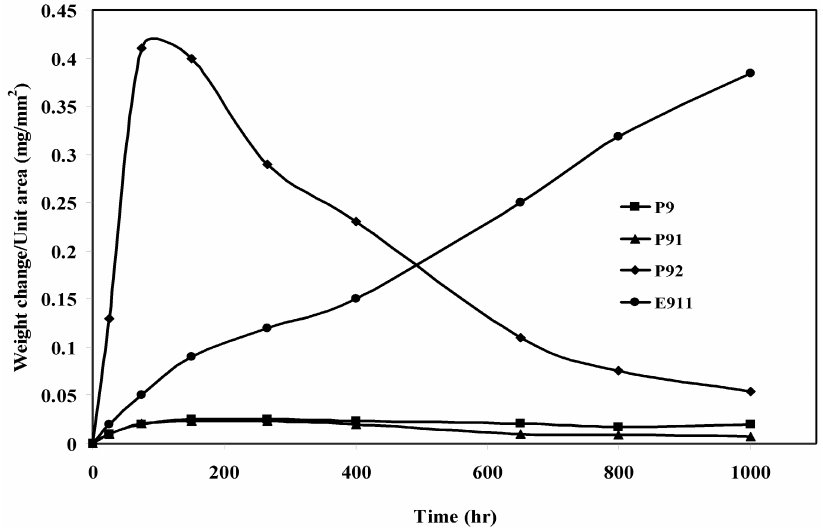
Figure 3. Weight change vs. time plots for the oxidation of alloys at 1073 K in air for 1000 h.